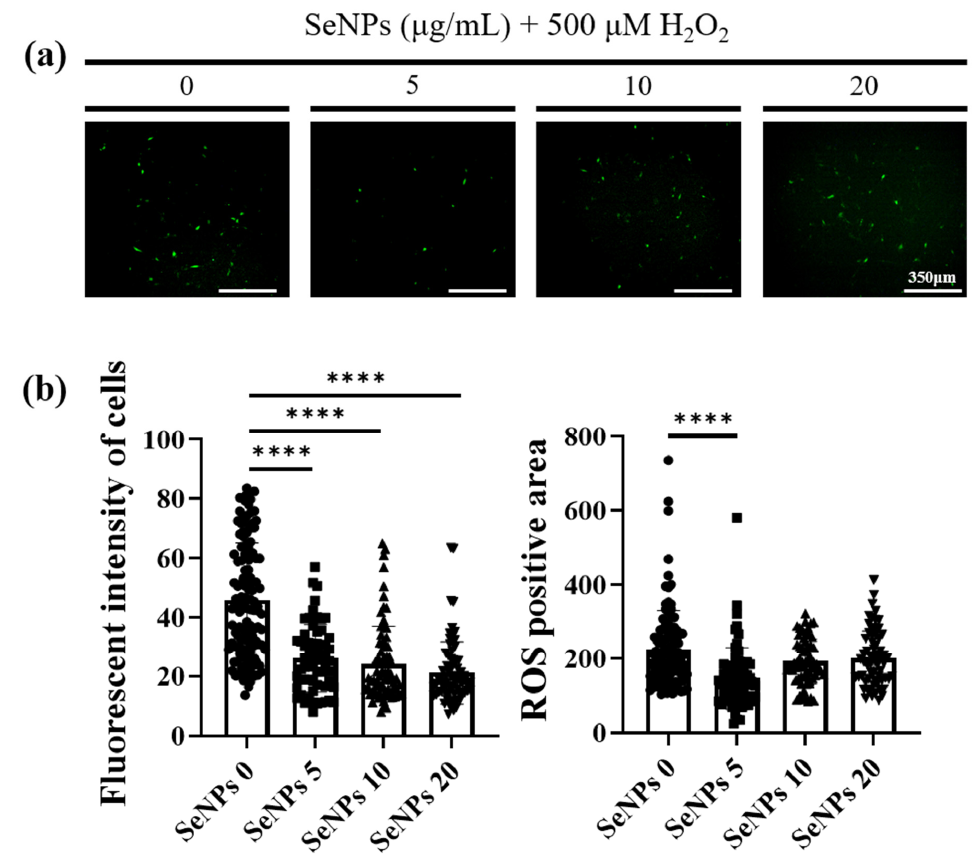
Figure 4. C2C12 cells were exposed to 500 µ M of H 2 O 2 to induce oxidative stress and then were recovered by culturing in a medium with or without SeNPs. High oxidative stress conditions were enabled by pretreatment with H 2 O 2 for 4 h. ( a ) SeNP treatment reduced the levels of reactive oxygen species (ROS). ( b ) The fluorescence intensity of cells and ROS-positive areas were measured using ImageJ. Statistical significance was calculated using one-way ANOVA, followed by a two-sided Dunnett post hoc test compared to the untreated SeNPs group (scale bar = 350 µm). **** Represents p < 0.0001; n = 5.